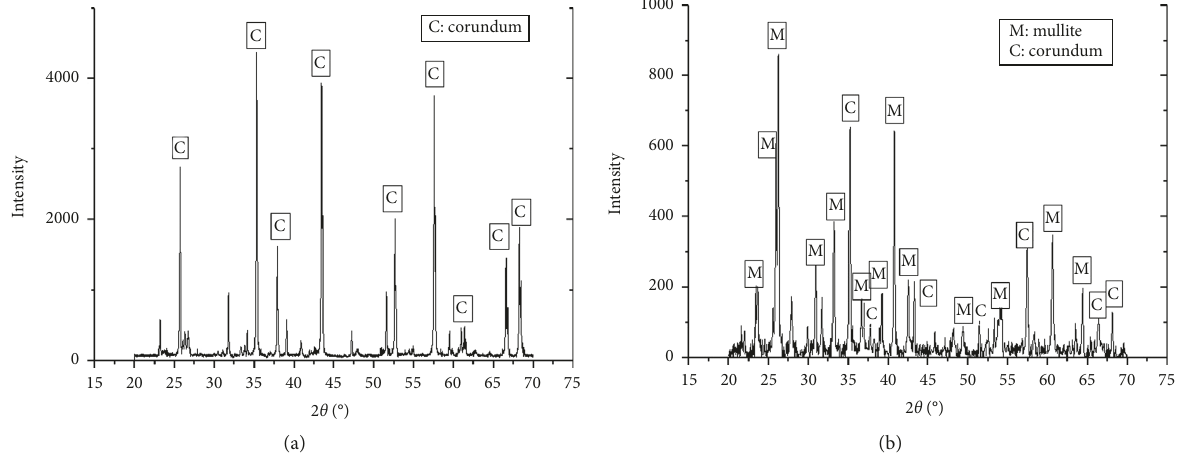
2 O 3 microceramic membrane. (b) X-ray